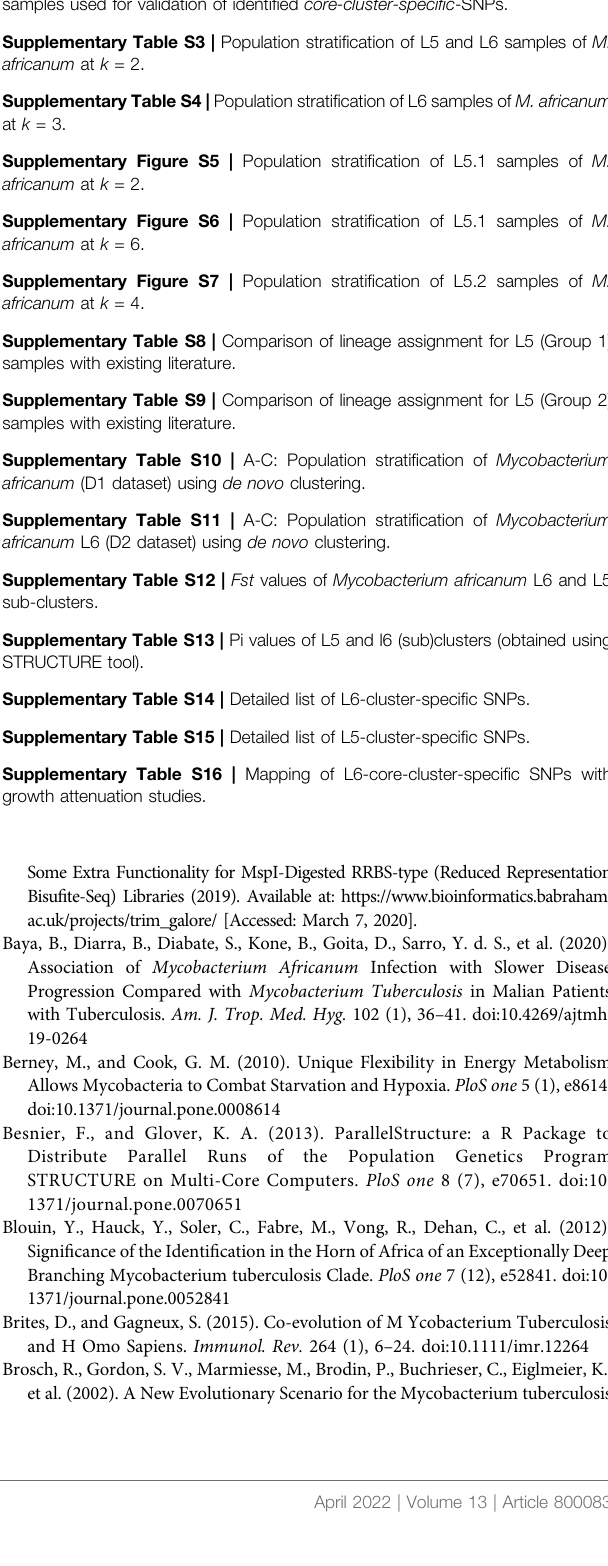
Supplementary Table S2 | Mapping of lineage for Mycobacterium africanum samples used for validation of identi fi ed core-cluster-speci fi c -SNPs. Supplementary Table S3 | Population strati fi cation of L5 and L6 samples of M. africanum at k = 2. Supplementary Table S4 | Population strati fi cation of L6 samples of M. africanum at k = 3.